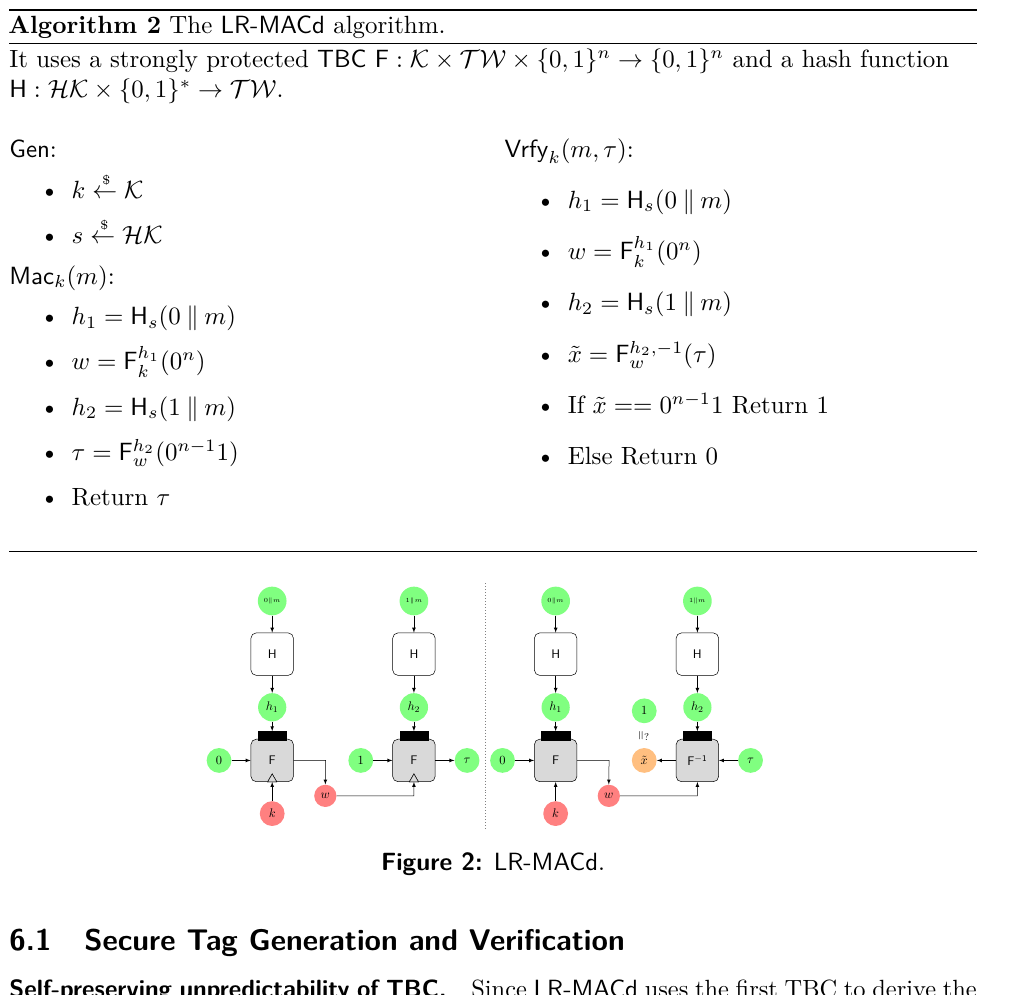
Algorithm 2 The LR-MACd algorithm.